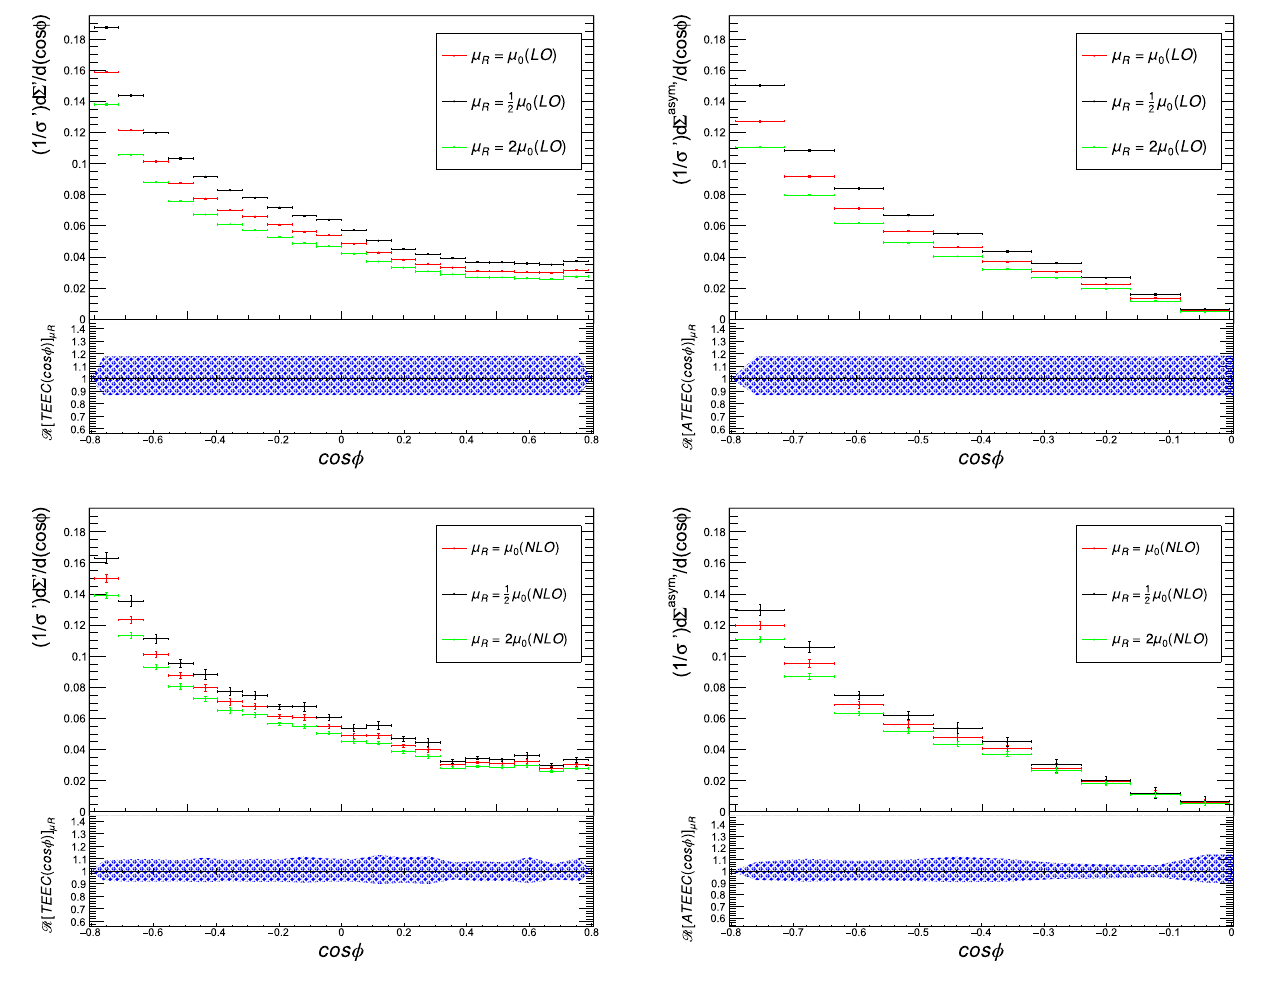
Fig. 6 Renormalization scale dependence of the differential distribu- tion 1 /σ (cid:7) d (cid:9) (cid:7) / d ( cos φ) and its asymmetry 1 /σ (cid:7) d (cid:9) (cid:7) asym / d ( cos φ) in the leading order (upper frames) and the next to leading order (lower frames) varying μ R in the range [ 0 . 5 , 2 ] × μ 0 , where μ 0 is the nom-